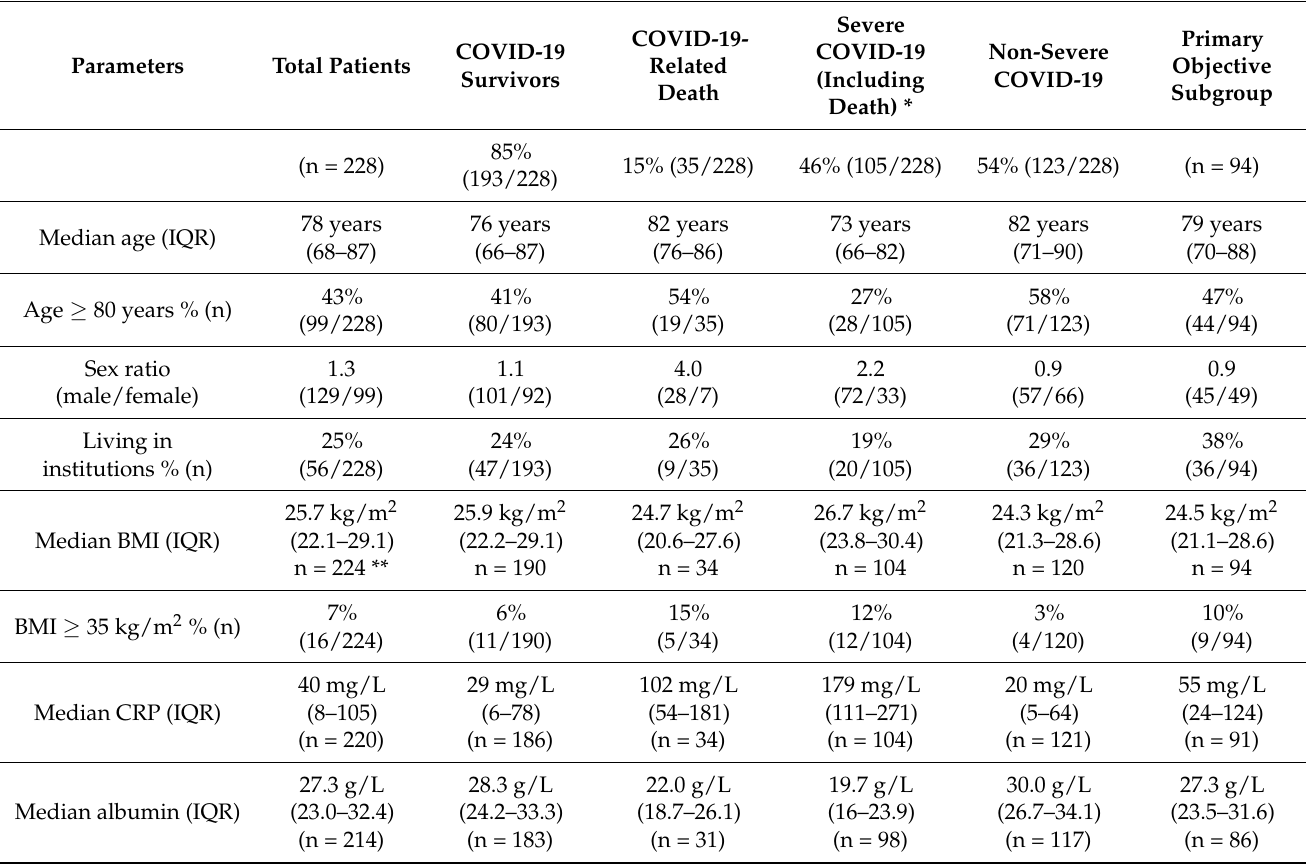
Table 1. Baseline demographics, comorbidities, biomarkers, and clinical outcomes of the 228 pa- tients, including the 94 patients with micronutrients analysis collected during the first 15 days of